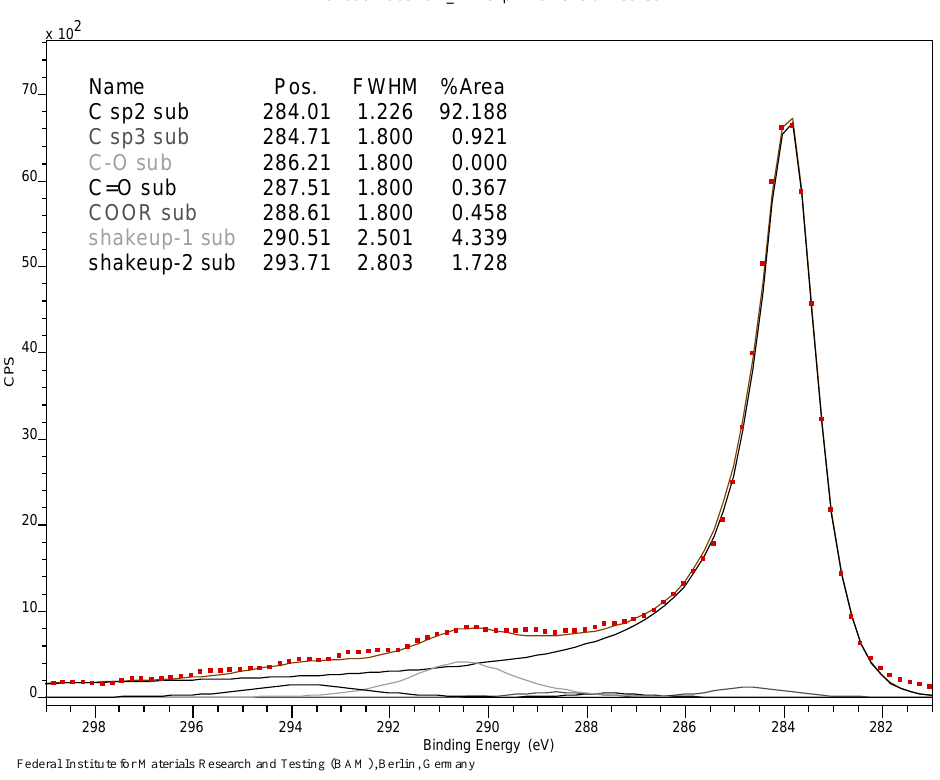
Figure 12. C-1s peak (XPS) of brominated MWCNT sample